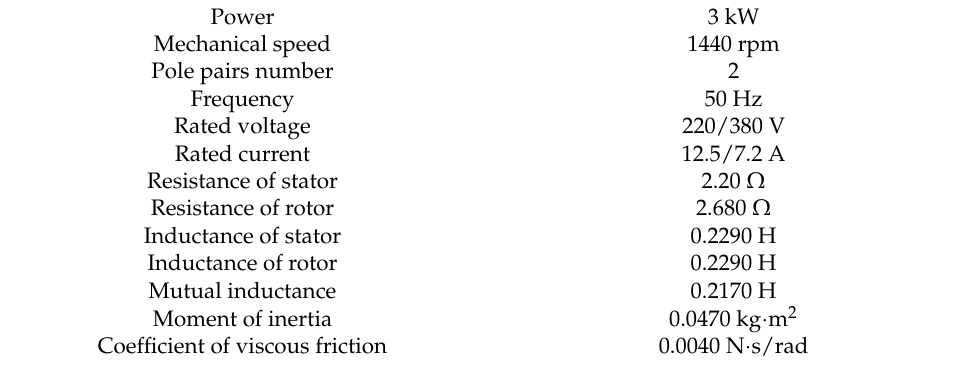
Table A1. The machine used in the simulation: rated power and